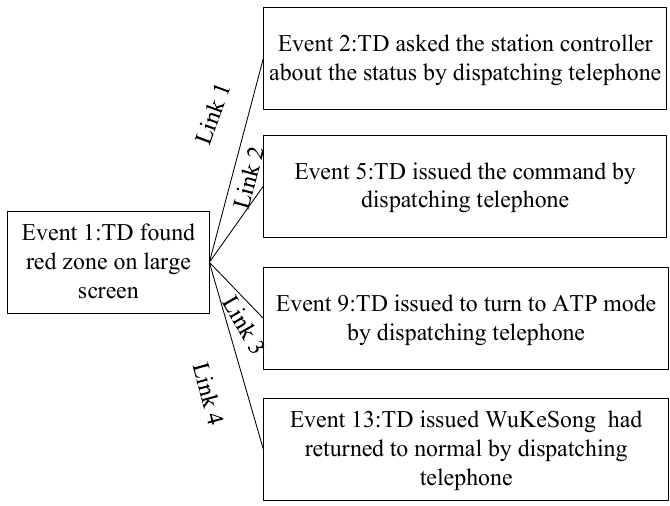
Figure 5. The mapping rules for the traffic dispatching team task.